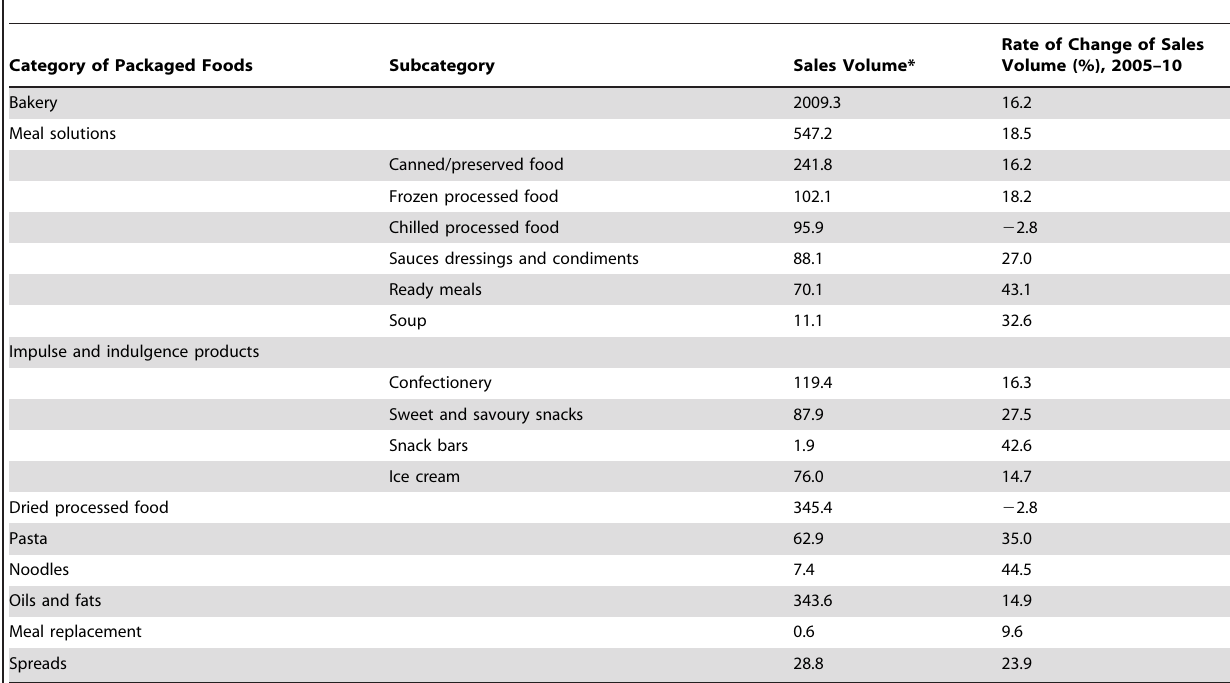
Table 1. Volume of sales of select leading categories of packaged foods, 2010, and rate of increase